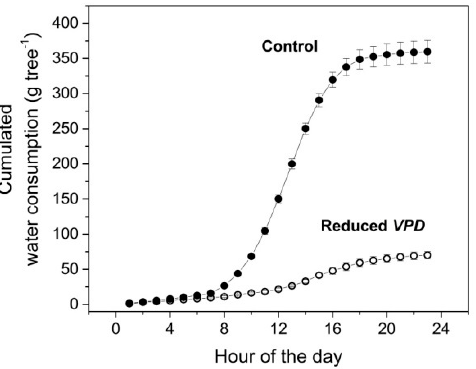
Figure 8. Cumulated diurnal plant transpiration measured in trees under control ( • ) and reduced VPD ( ○ ) by means of bag application. Each point is the average of 6 trees, bars (± SE) are visible when larger than symbol. Data relates to day 8th of experiment.